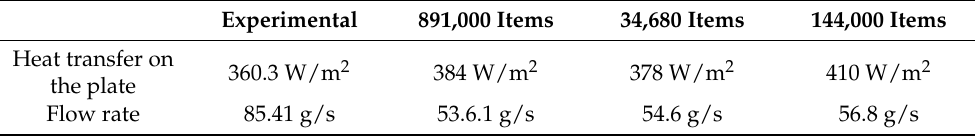
Table 2. Comparison of the experimental model for the mesh independence test.